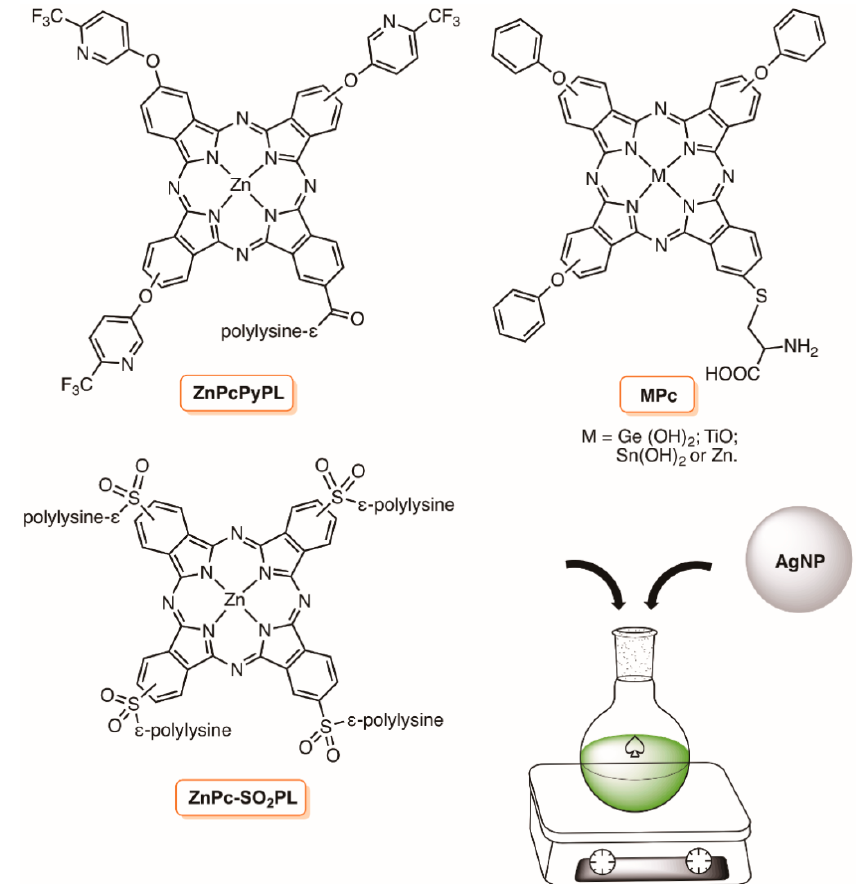
Figure 6. Structures of metal phthalocyanines used in the preparation of phthalocyanine-AgNPs conjugates (adapted from References [66,67]).